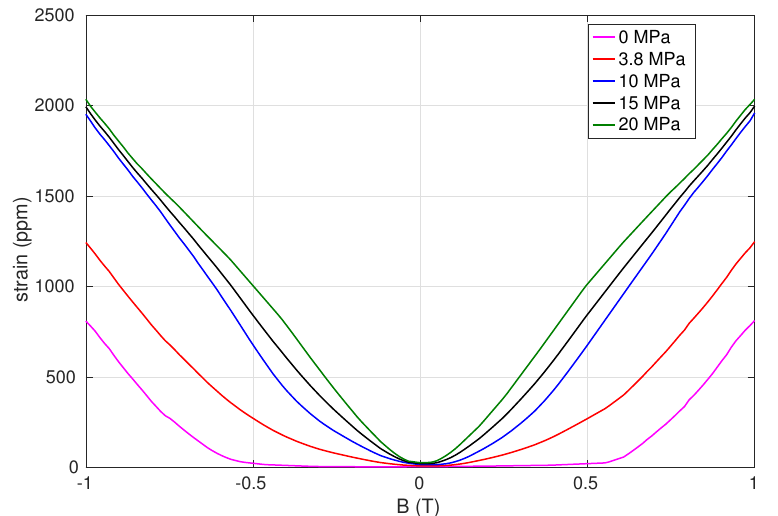
Figure 3. Experimental magnetostrictive strain of the Terfenol-D at increasing mechanical pre-stresses. The curves are necessary to establish the mechanical pre-stress and the magnetic bias of the MS